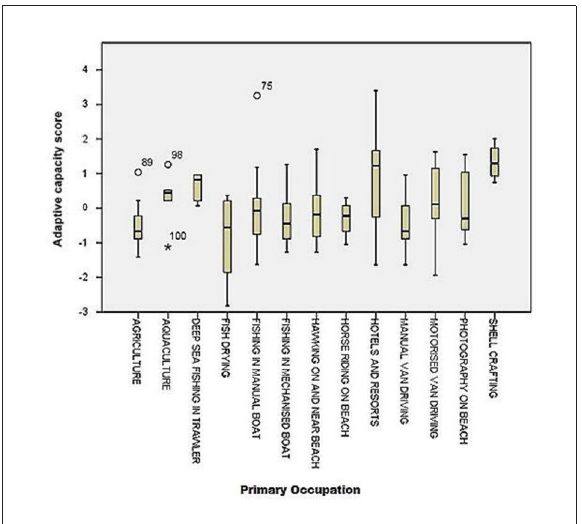
FIGURE8 Box plot of adaptive capacity scores. Source: Primary survey based